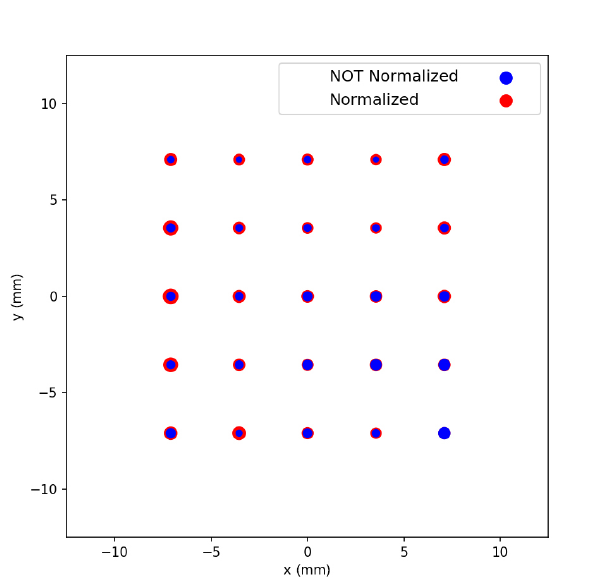
Figure 7. Tactile map of normalized values (red dots) vs. not-normalized ones (blue dots), during the grasping of a rigid flat